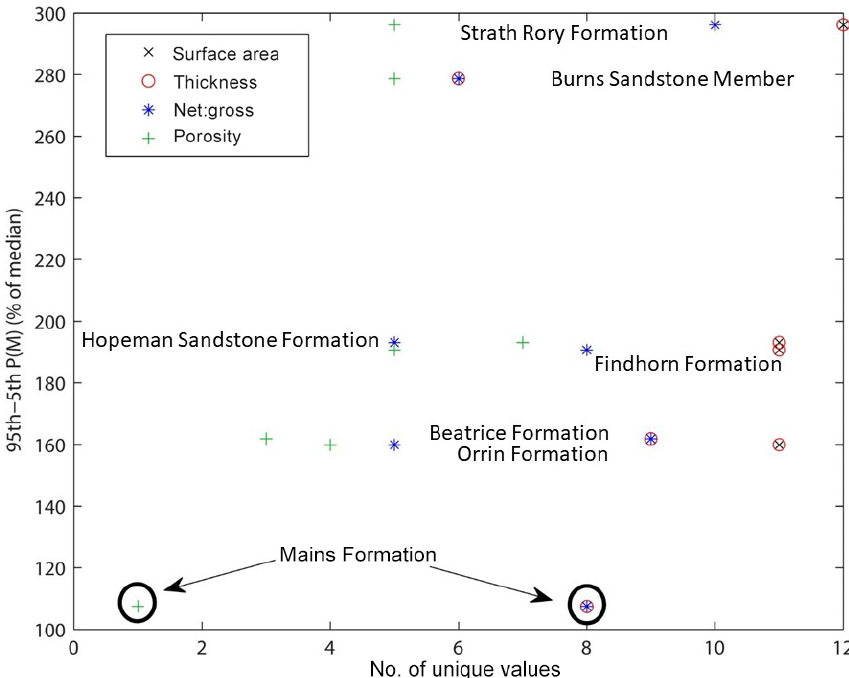
Figure 3. The range of P(M) (5th–95th percentile) against number of unique values for the area, thickness, net:gross ratio and porosity.